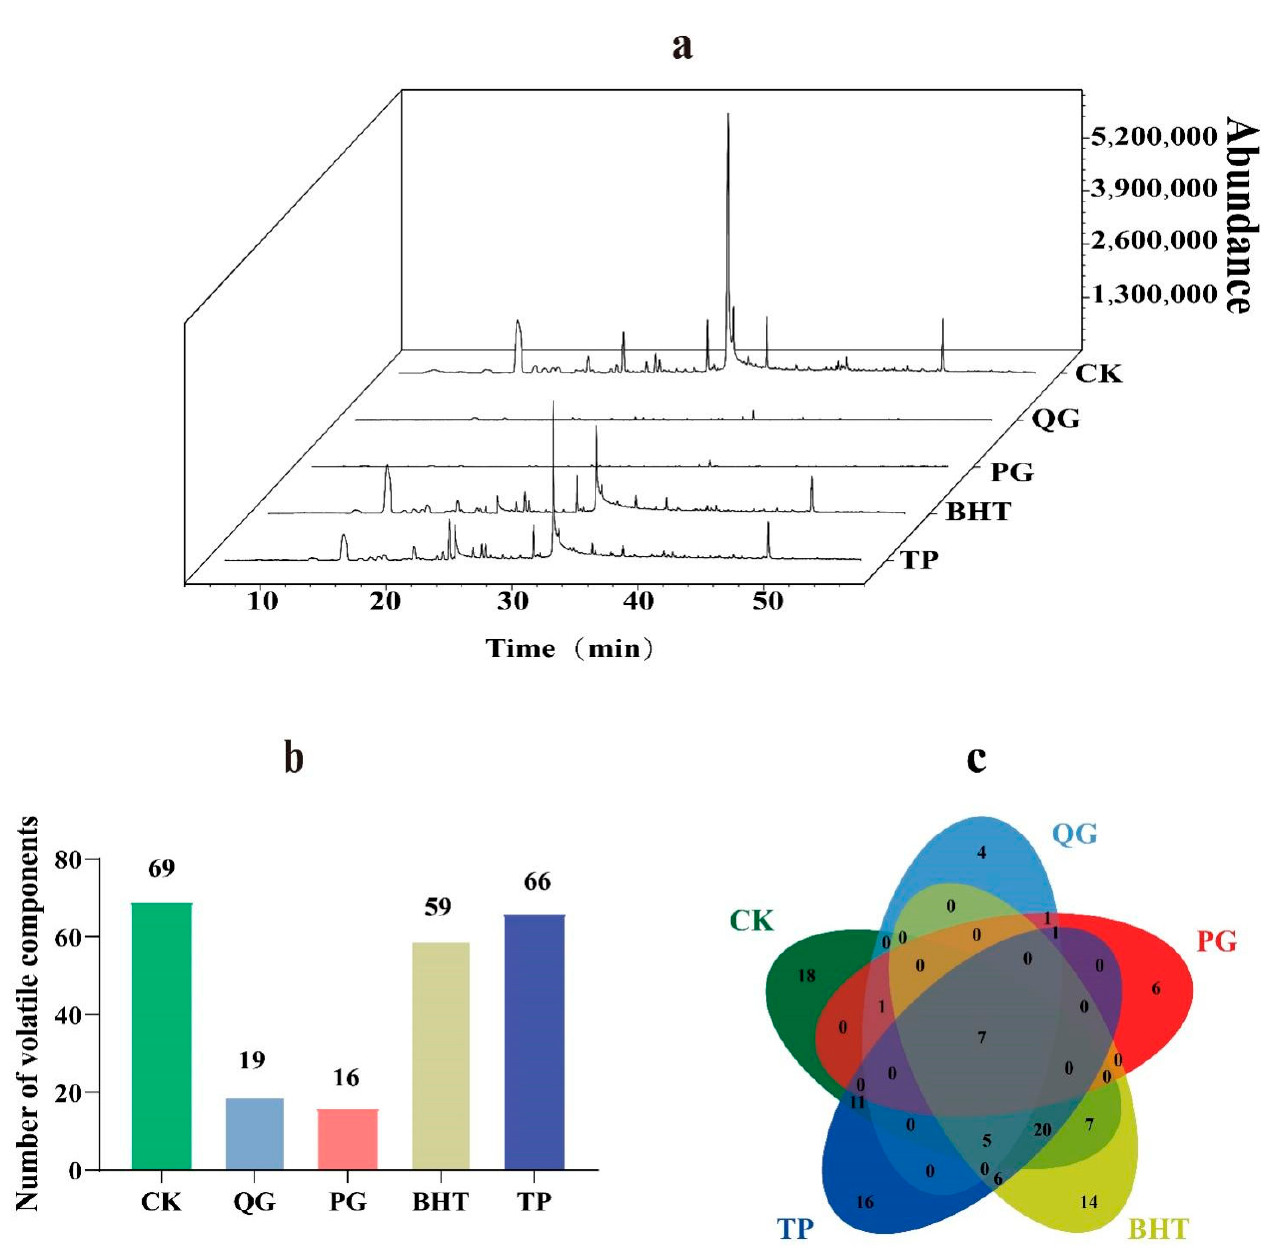
Figure 5. Total ion chromatograms (TIC) of soybean oil treated with different antioxidants via HS- SPME-GC-MS ( a ); the number of volatile components ( b ); Venn diagram of volatile components ( c ).